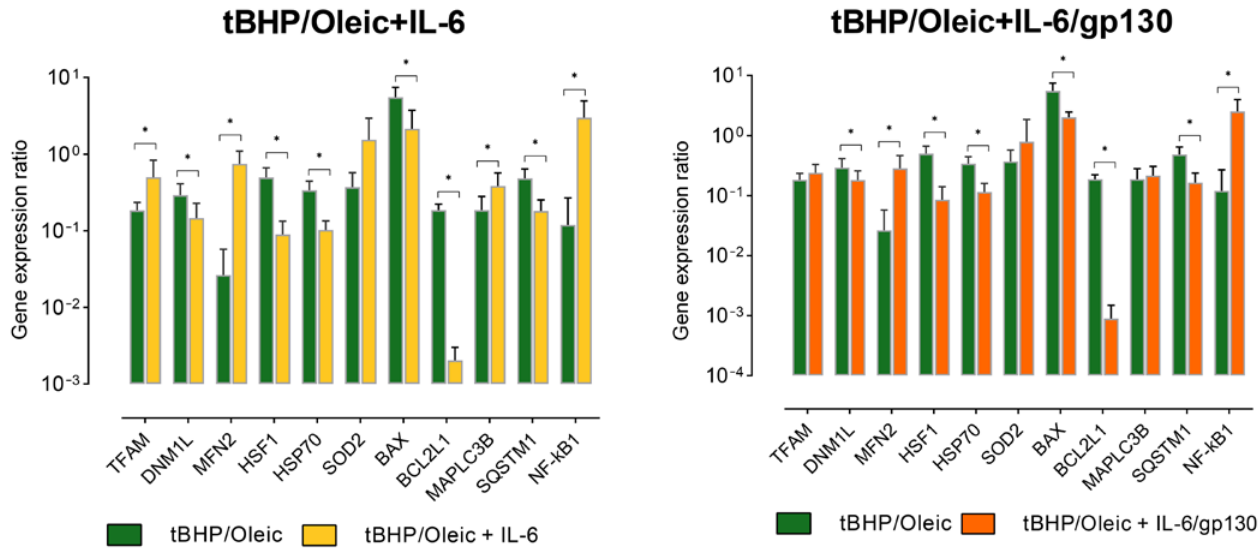
Figure 5. The level of gene expression in HepG2 cell models with the addition of IL-6 and IL- 6/gp130; Mean ± SD; *— p < 0.05 .